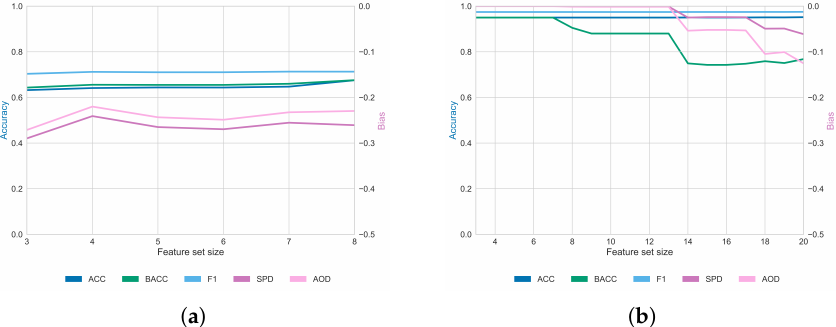
Figure 5. Performance results for LRC on various feature set sizes of different orders. Model performance was evaluated using stratified 10-fold CV. For SPD and AOD, values closer to zero indicate more fairness. ( a ) COMPAS; ( b )